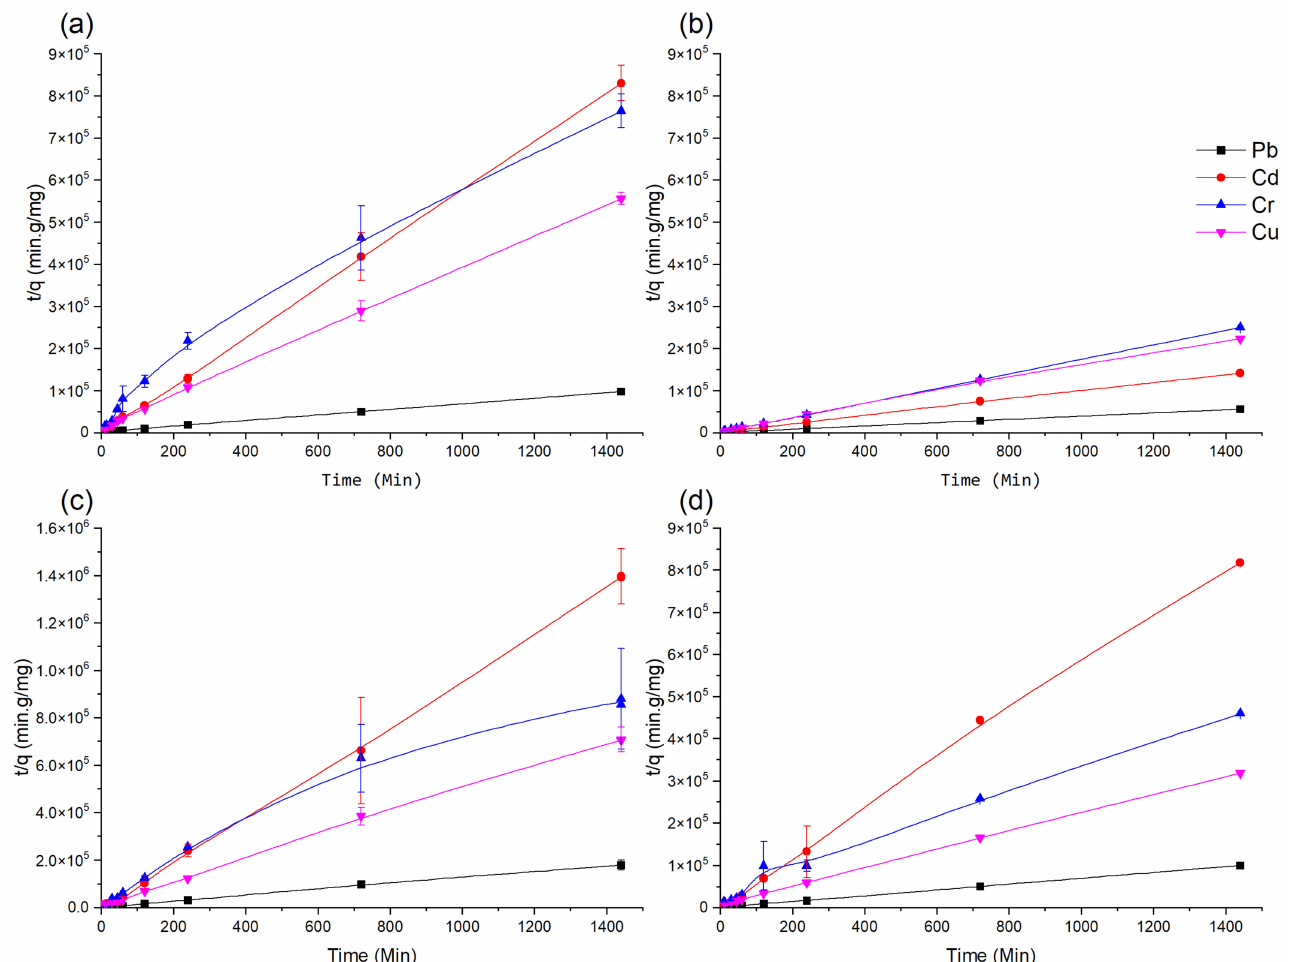
Figure 5. Pseudo-second-order model: ( a ) Coffee husk, ( b ) AgNPs–coffee husk, ( c ) lignin, and ( d )